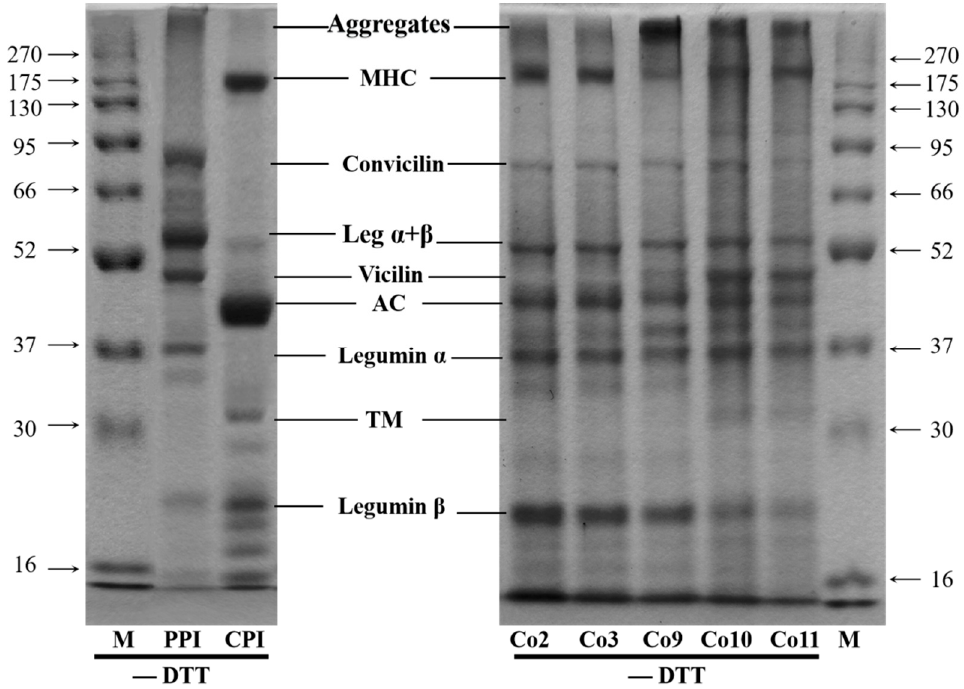
Figure 2. Non-reduced electrophoretic map of PPI, CPI and Co prepared under different extraction pH conditions. Table 1. The relative optical density of Co non-reduced electrophoretic bands prepared under different extraction pH conditions